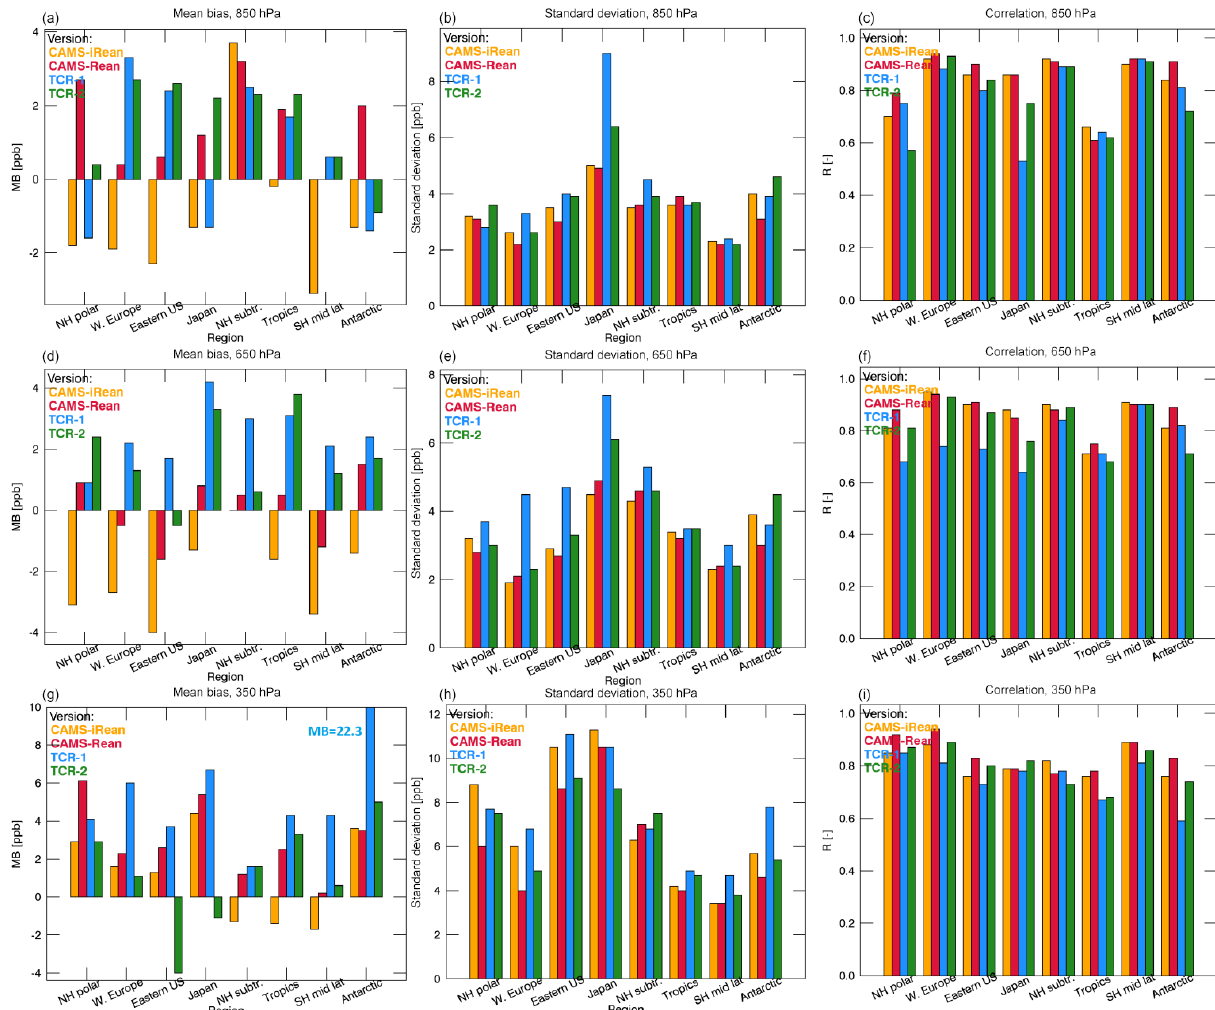
Figure 3. Evaluation of ozone mean bias (reanalysis minus observation, a , d , g ), standard deviation of the unbiased differences (b, e, h) , and temporal correlation R (c, f, i) for the four reanalysis products at 850 (a–c) , 650 (d–f) , and 350 (g–i) hPa against sondes, computed for various regions, for the 2005–2016 time period. Table 5. Mean bias (ppb) for the reanalyses against TOAR monthly mean and regional mean observations for the 2005–2012 time period, as sampled for observations in the specified regions indicated in Fig. 7. Arctic Europe Eastern Western Southeast East SH middle